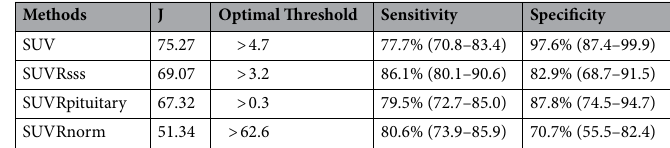
Table 9. Optimal threshold of each method as determined by Youden’s J Statistics with 95% confidence interval.